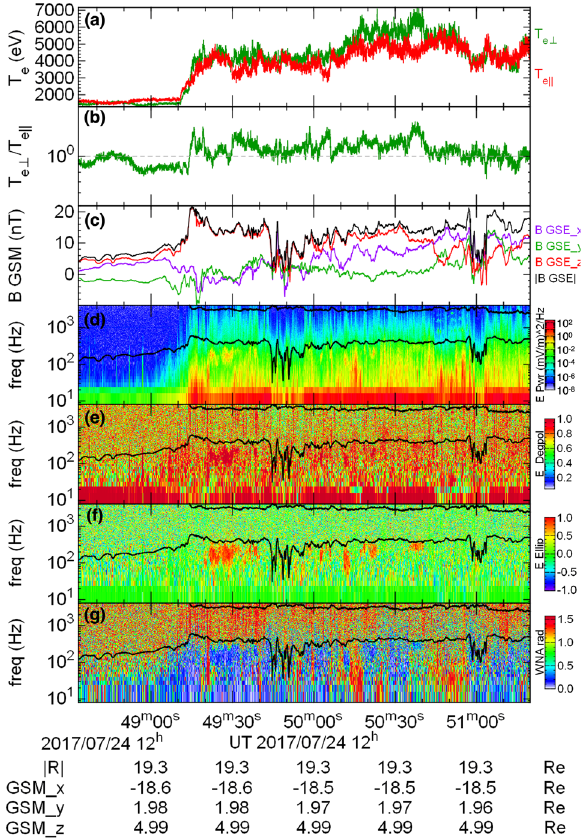
Figure 5. In situ observations of the wave activity and electron distribution in a dipolarization flow at MMS3 are fully consistent with the emergence of the mesoscale pattern of interchanging regions of parallel and perpendicular anisotropies predicted in our test particle simulations. Panel ( a ): electron temperature; panel ( b ): the ratio of the perpendicular and parallel temperatures - the scale is equivalent to in Fig. 1; panel ( c ): magnetic field intensity; panel ( d ): electric field power spectral density; panel ( e ) electric field polarization; panel ( f ): electric field ellipticity, with negative (positive) values indicating left (right) hand polarization; panel ( g ): wave normal angle. Black traces in ( d )–( g ) are the electron plasma frequency (upper trace) and electron cyclotron frequencies